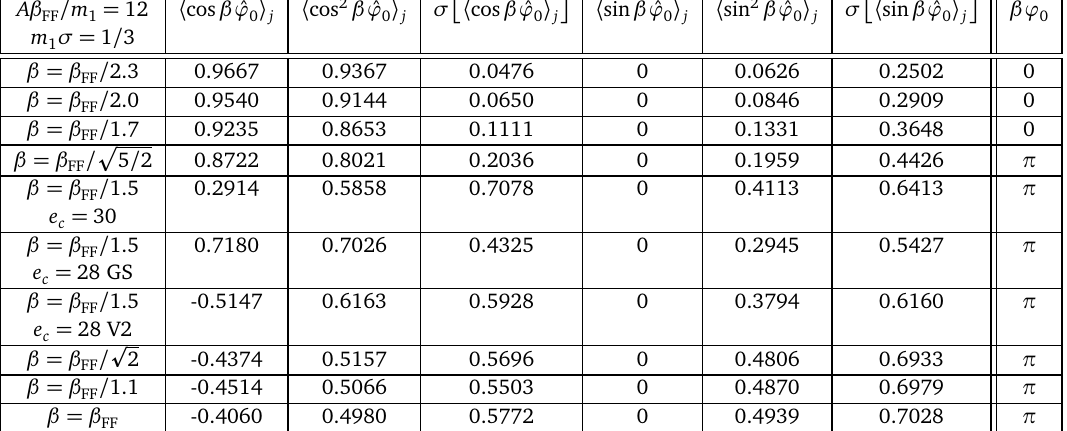
= 30, c in the inhomogeneous O